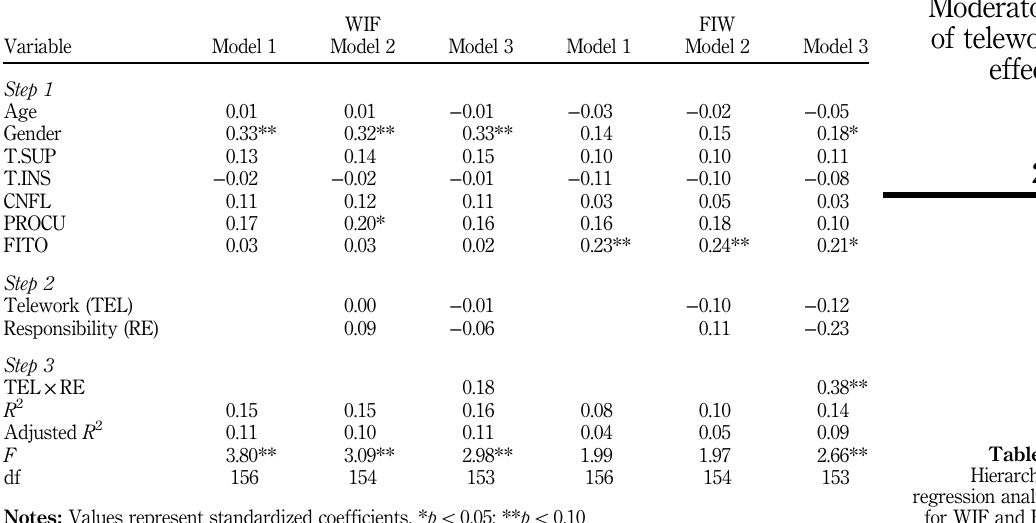
regression analysis for WIF and FIW